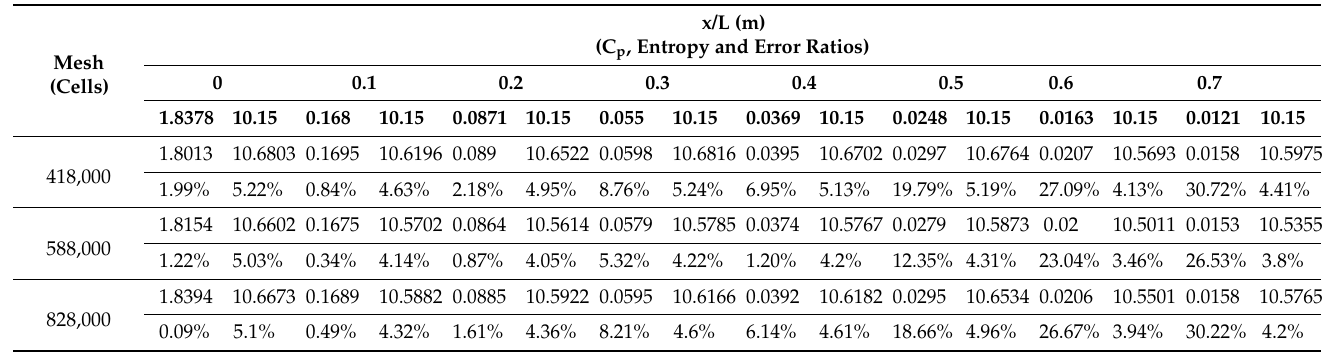
Table 6. Grid independency study of three levels of different mesh with error ratios for pressure coefficient and entropy at a far-field distance is 20